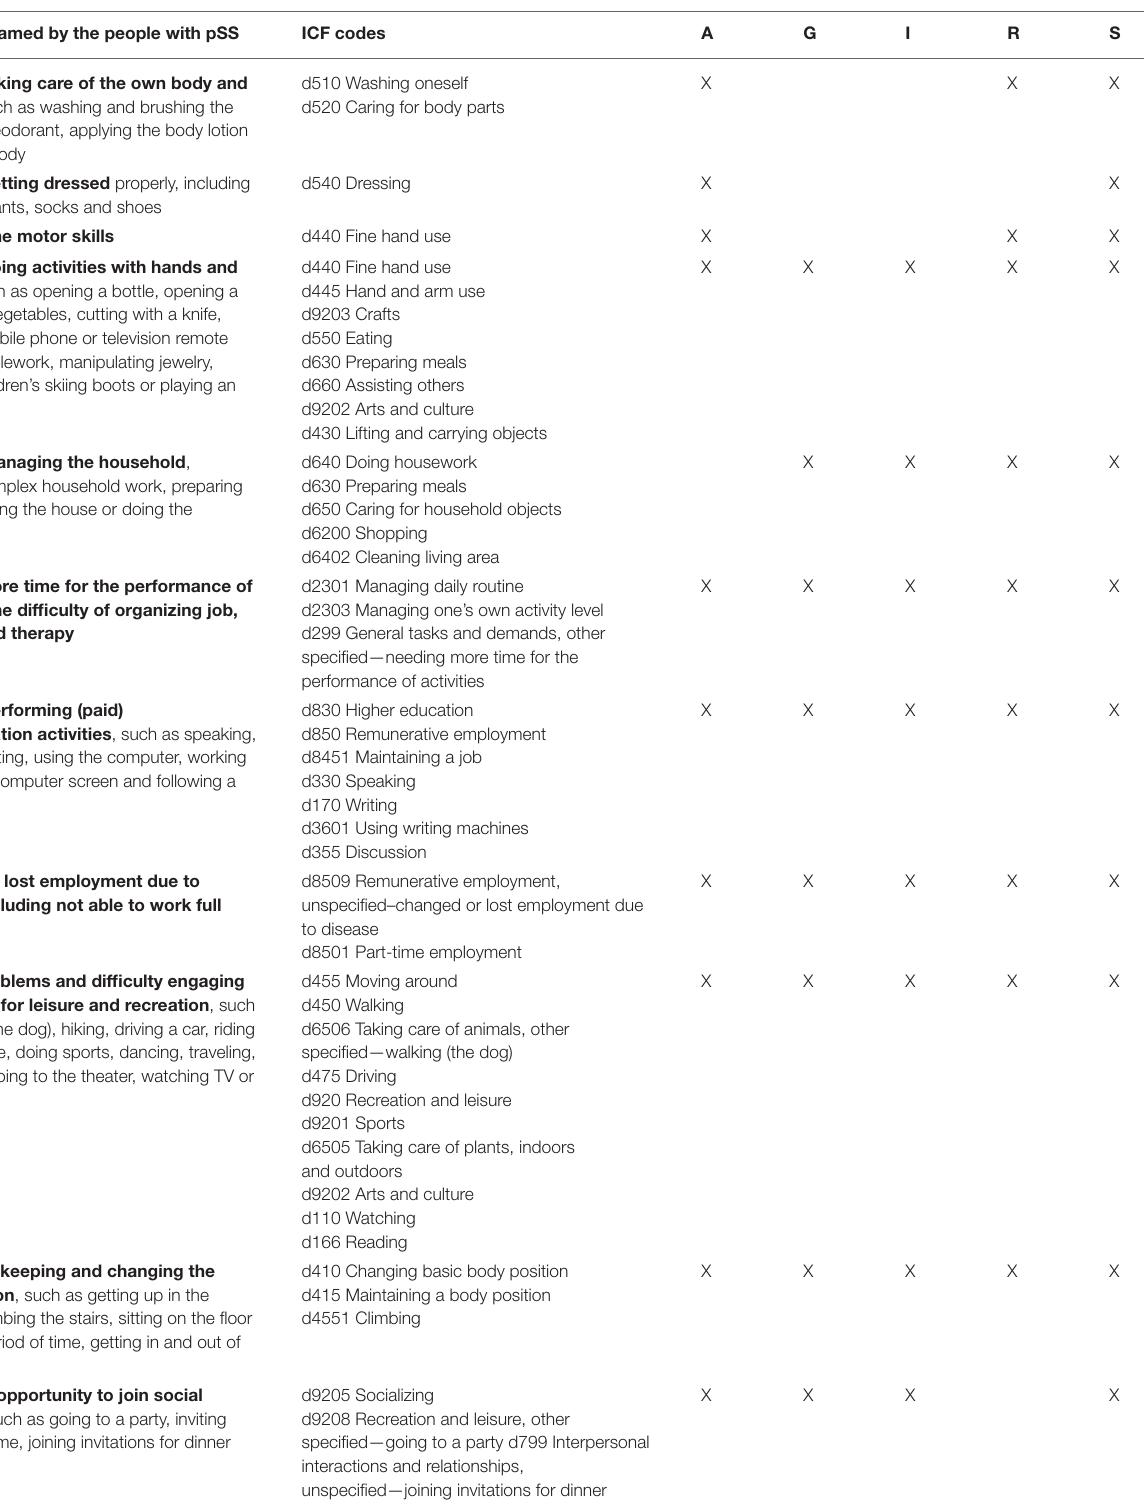
TABLE 2 | Activities and